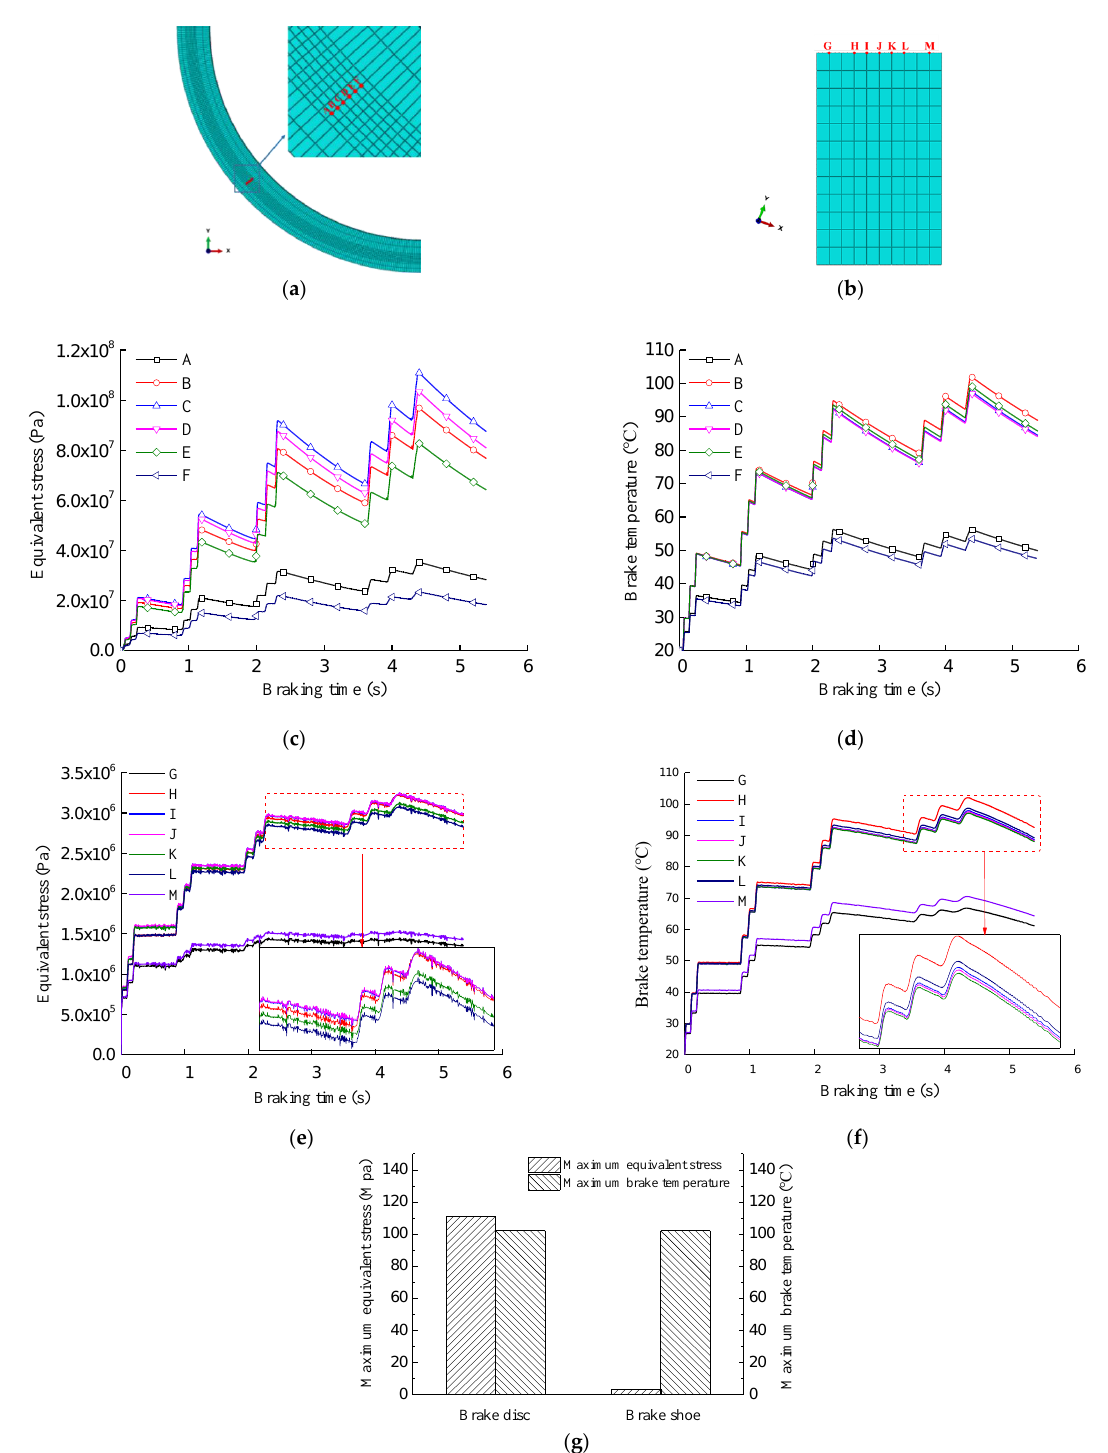
Figure 13. Equivalent stresses and temperature of the brake disc and the brake shoe during emergency braking. ( a ) Reference points at the contact surface of the brake disc. ( b ) Reference points at the contact surface of the brake shoe. ( c ) Evolutions of equivalent stresses of reference points at the contact surface of the brake disc. ( d ) Evolutions of temperature of reference points at the contact surface of the brake disc. ( e ) Evolutions of equivalent stresses of reference points at the contact surface of the brake shoe. ( f ) Evolutions of temperature of reference points at the contact surface of the brake shoe. ( g ) Maximum equivalent stresses and temperature of the brake disc and the brake shoe.